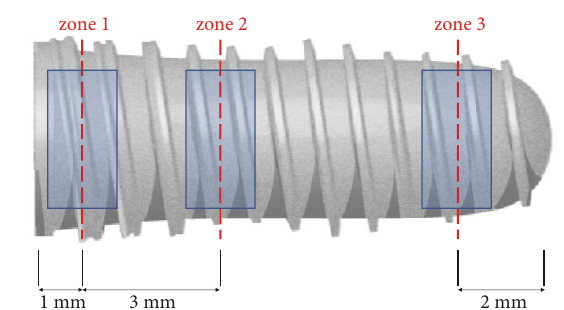
Figure 2: Zones and regions of interest (ROI) for particle count measurement defined for study purposes. Three zones (red dash- line) were selected at 1 mm and 4 mm from the collar and at 2 mm from the apex each. For each zone, two ROIs (blue rectangle) were analyzed at opposite sides of the implant (6 ROIs per